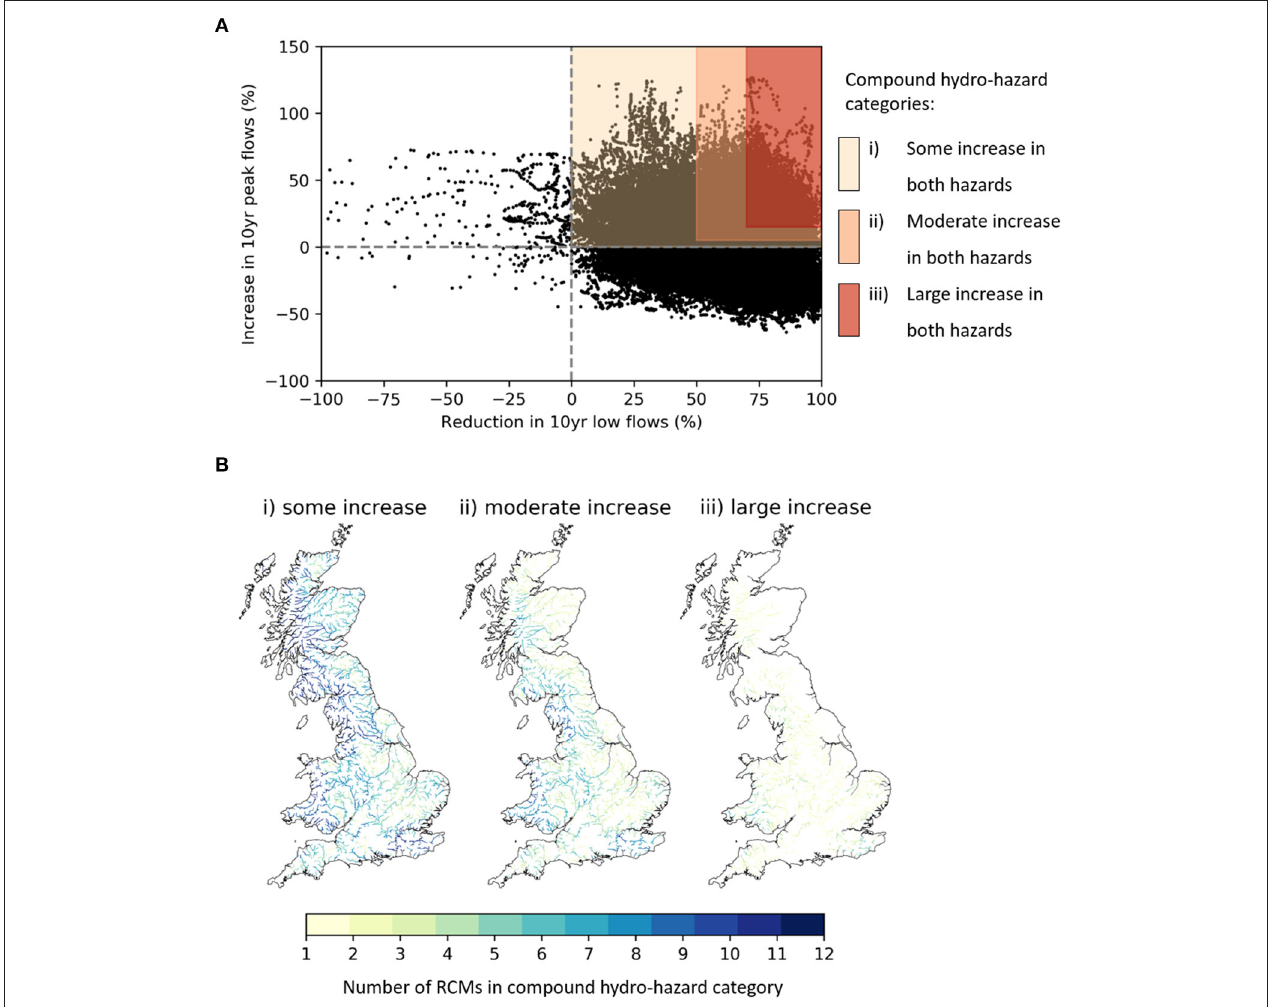
FIGURE 5 | Projected increases in compound hydro-hazards, where both high and low flow events intensify. The changes to 10-year high and low flows for all non-tidal river pixels and all ensemble members are given in (A) , which demonstrates the three categories used to define increases in compound hydro-hazards. Maps in (B) show the number of RCM ensemble members which have projected increases in each